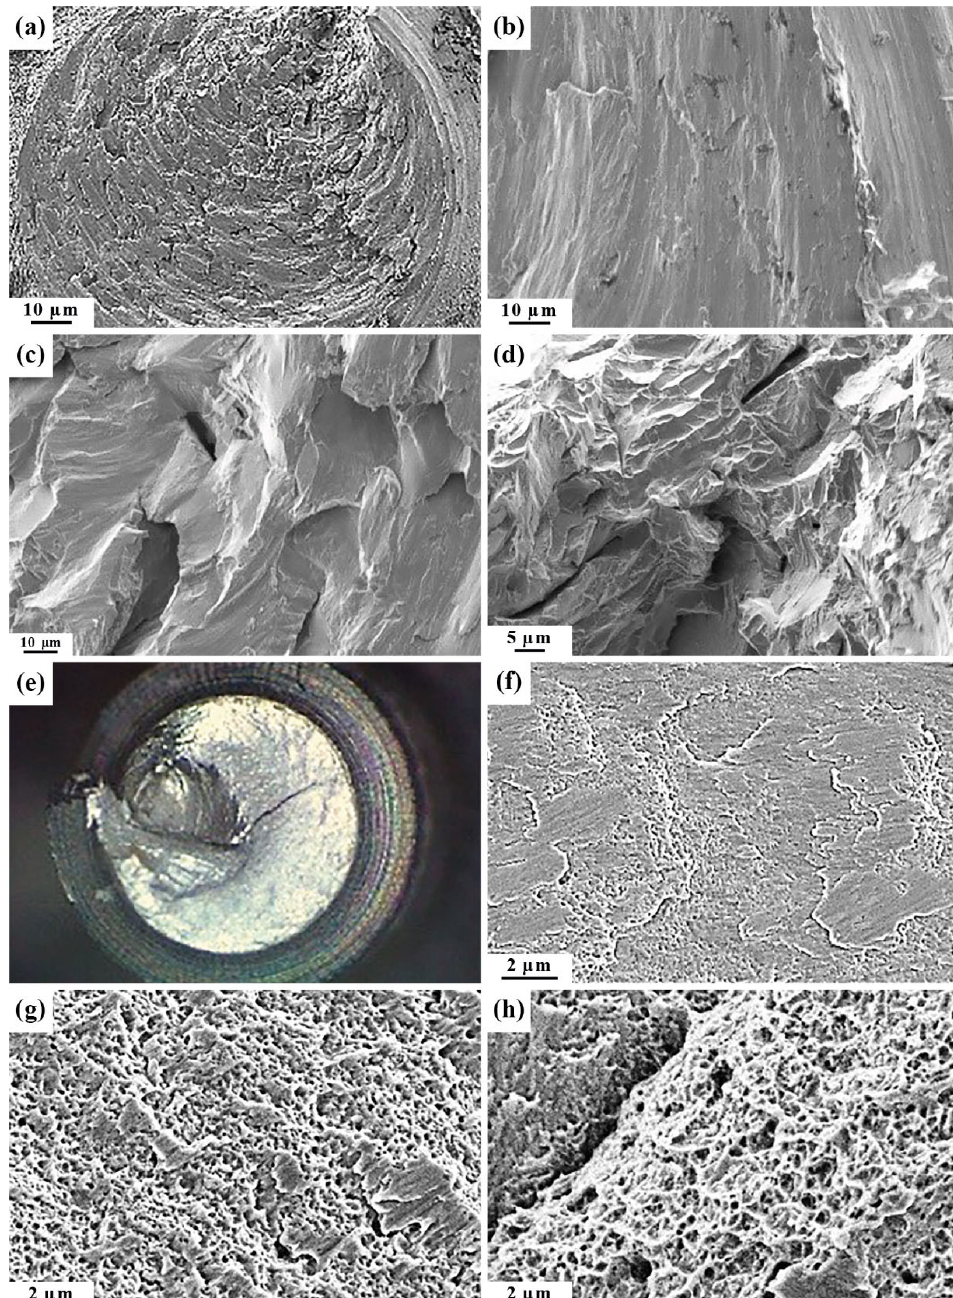
Figure 10. Characteristic view ( a,e ) and microrelief of the fracture surfaces for the screws from CG ( a – d ) and UFG ( e – h ) Ti. The microrelief was obtained in the peripheral ( b , f ), transitional ( c , g ) and central ( d , h ) parts of the fracture surfaces; ( b ) ×1000; ( c ) ×850; ( d ) ×750; ( f – h ) ×6000.